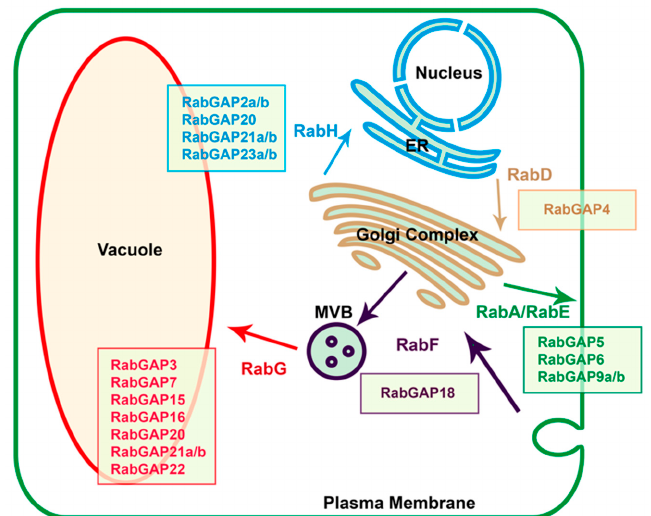
Figure 4. Identification of proposed protein-protein interactions between RABs and RabGAPs. The vesicular trafficking routes directed by the RabGTPase subfamilies between the different organelles and membranes are represented by arrows. RabGAP proteins were associated to each RabGTPase using the protein-protein interaction functional networks provided by the STRING database [41]. ER: Endoplasmic Reticulum. MVB: Multi-Vesicular Body. All proposed protein-protein interaction networks are detailed in Table S4.